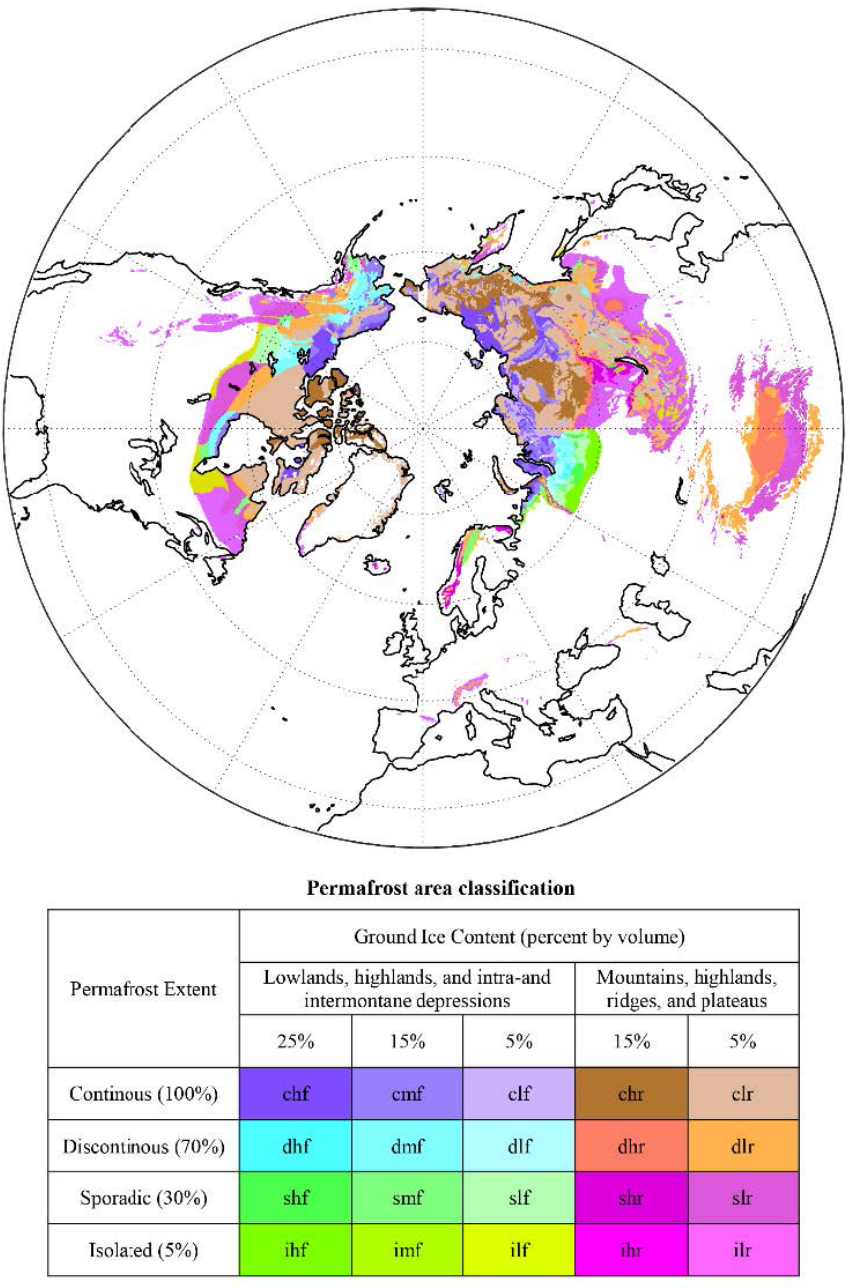
Figure 2. Spatial distribution of excess ground ice in the Northern Hemisphere modified from Brown et al. (1997). Compared to the original data, permafrost extents and ground ice contents are converted to definite numbers (percentages) for model